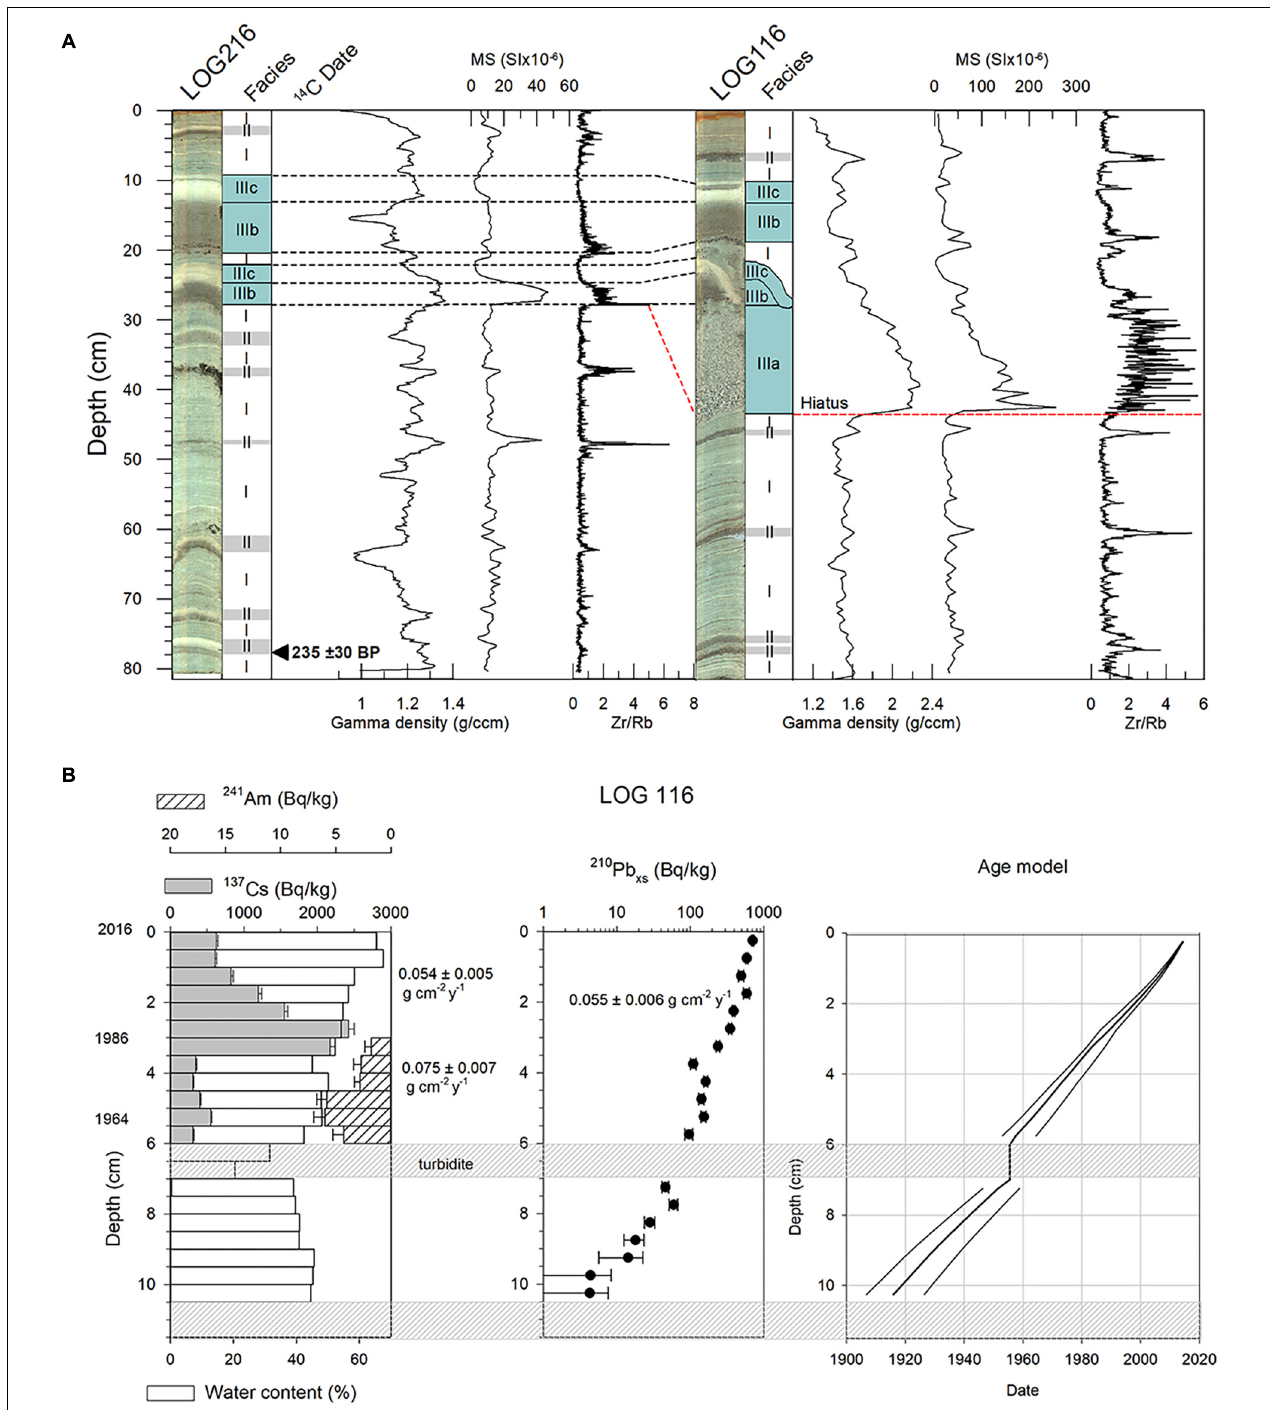
FIGURE 7 | (A) Photographs of LOG216 (left) and LOG116 (right) with corresponding measurements of gamma ray density, Magnetic Susceptibility (MS), and Zr/Rb-ratios from the XRF scanning. (B) Age-depth model for the upper section of LOG116 based on 137 Cs, 210 Pb, and 241 Am.